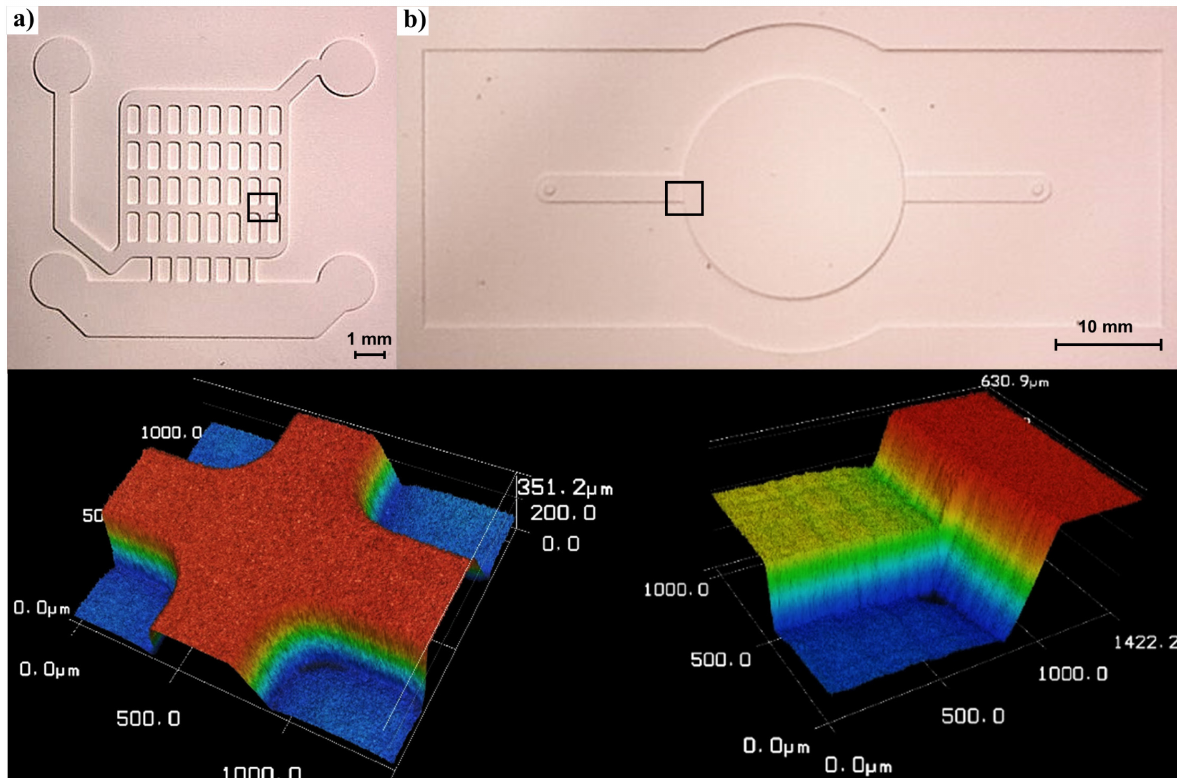
Figure 5. Two ceramic mold chips processed by laser ablation. Black squares mark the positions of the laser scanning microscope images below the mold images. ( a ) A 30 × 30 mm 2 chip for a microfluidic pattern with 240- μ m channel height. ( b ) Larger structure (33 × 76 mm 2 ) for the cell culture system with heights of approximately 230 μ m (horizontal inlet and outlet channels) and 465 μ m (circular area). Please note that the measures given in the images for the vertical scaling refer to a larger measuring